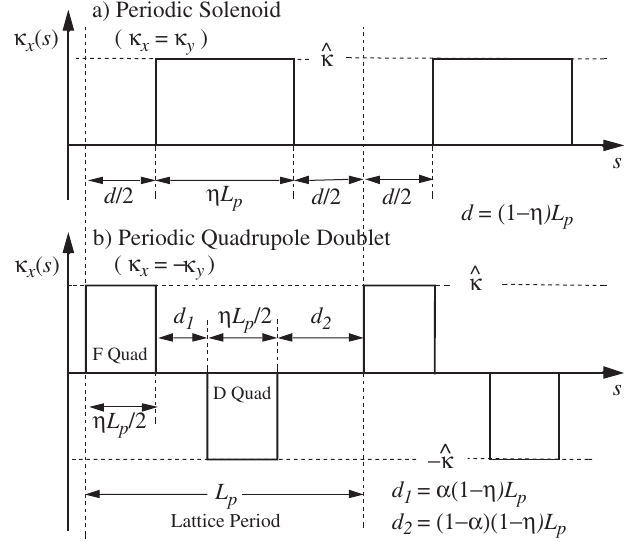
FIG. 1. Periodic (a) solenoid and (b) quadrupole focusing lattices with piecewise constant (cid:3)